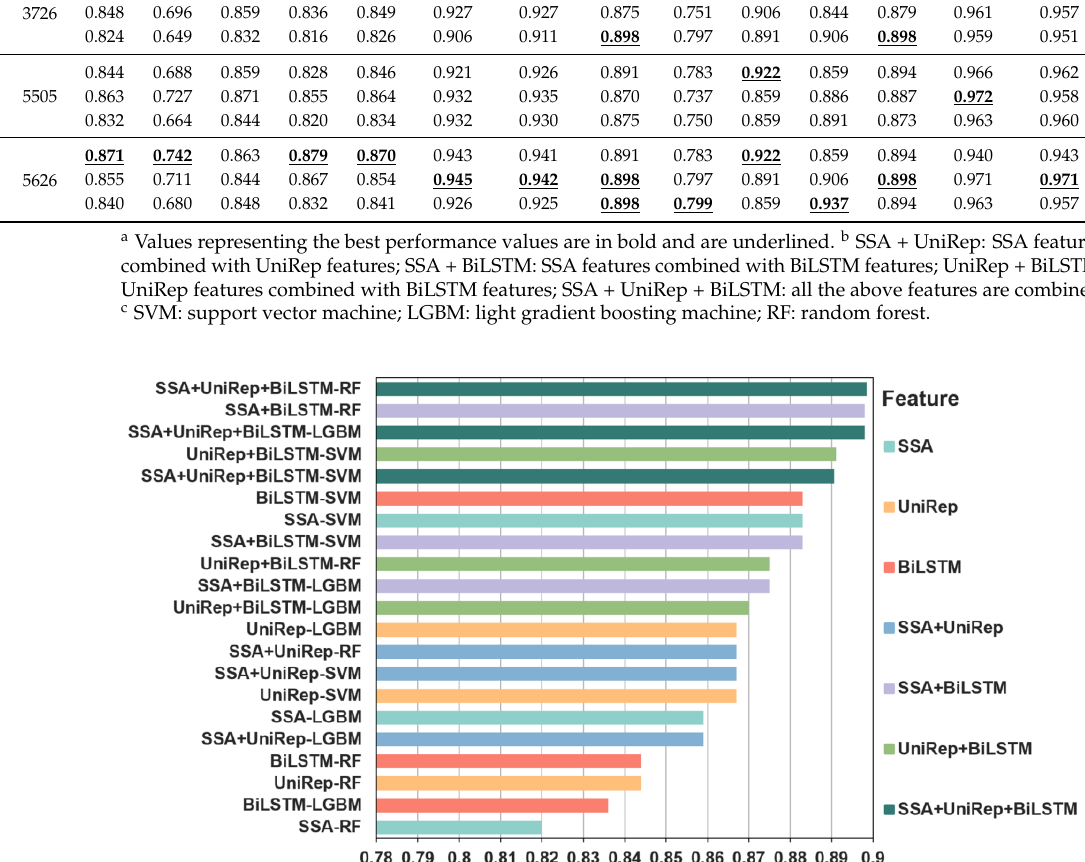
Figure 2. The accuracy of independent tests for predicting individual and fused features of bitter peptides. Three individual features, SSA, UniRep, and BiLSTM, three double fusion features, SSA + UniRep, SSA + BiLSTM, and UniRep + BiLSTM, and a triple fused feature, SSA + UniRep + BiLSTM, were tested with three distinct machine learning algorithms. The same color is used to signify the same features. The accuracy of the individual or fused feature/machine learning algorithm combi- nations is ranked from highest to lowest. The accuracy of one of the triple fusion features and four fused double features outperformed the best performing individual feature. In contrast, the four least accurate predictors were individual feature models, indicating the superiority of fused fea- tures. The accuracy of the SSA + UniRep + BiLSTM-LGBM) combination was 0.898. The best per- forming SSA-SVM and BiLSTM-SVM individual features had an accuracy of 0.883. In summary,